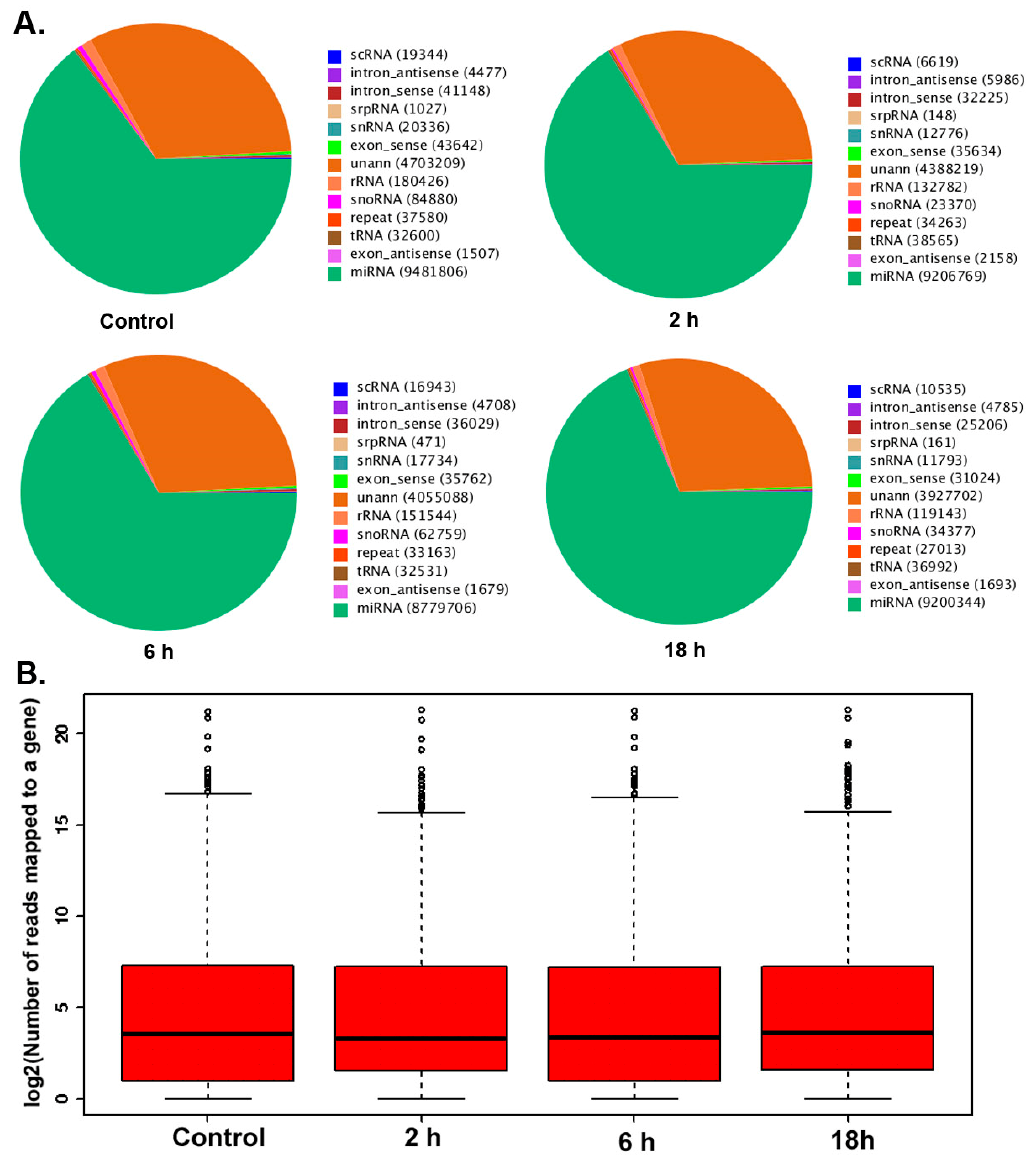
Figure 2. ( A ) The number of small nucleotides in different experimental groups. ( B ) MicroRNA two generation sequencing data box of each experimental group.